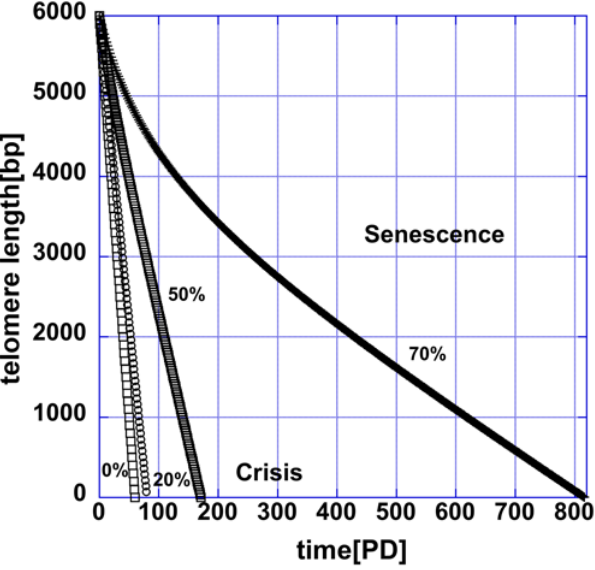
Figure 3. In the presence of telomerase inhibitor, telomerase is incapable of preventing the appearance of a critically short telomere. The attrition of telomeres at different telomerase inhibition level is shown for several telomeres with the same initial length. The time to the crisis point for each cell determines the proliferative potential of that cell.